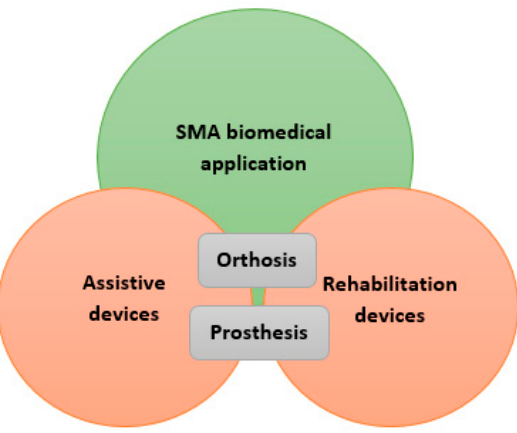
Figure 1. Schematic representation of sections studied in this paper.